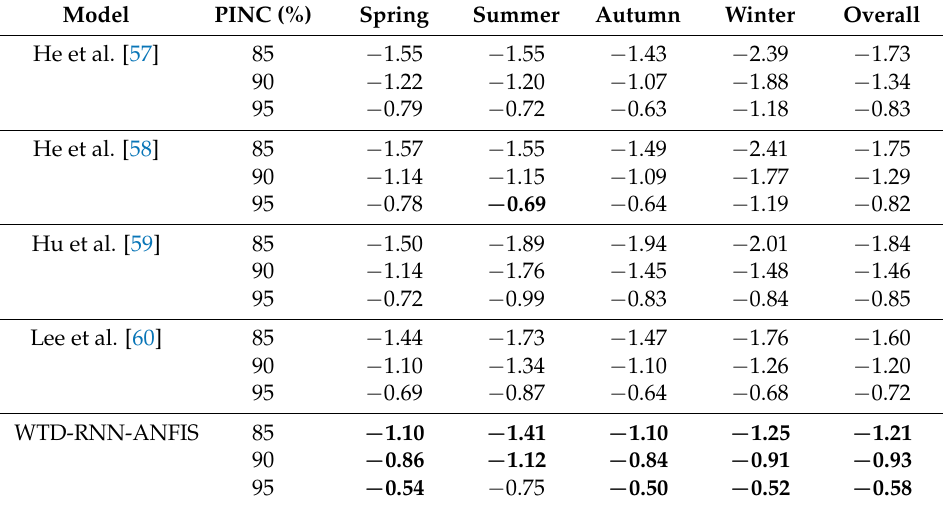
The numbers in bold are the best criteria of each studied case. Table 8. Comparisons of the criterion IS for probabilistic wind speed forecasting. Model PINC (%) Spring He et al.